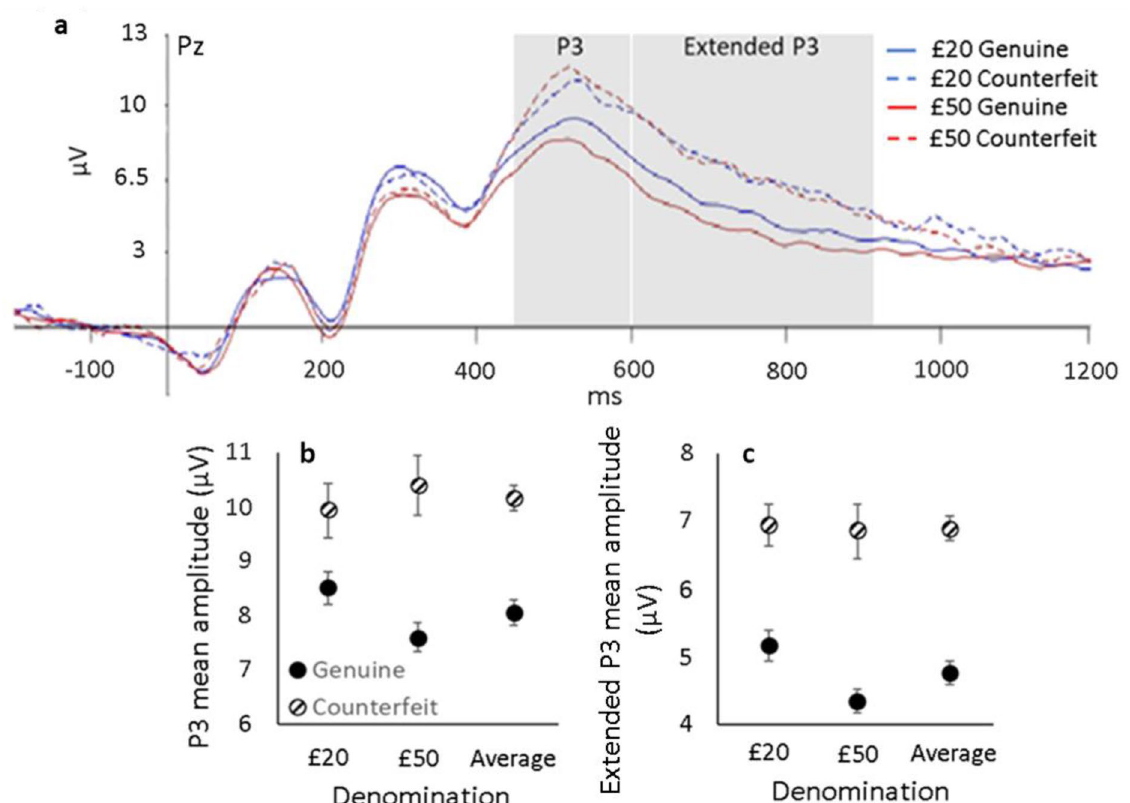
Figure 2. ( a ) ERP for each denomination and authenticity at electrode location Pz, where the P3 component mean amplitude within the 450–600 ms window is calculated. Blue lines represent £20 notes, red lines represent £50 notes. Solid lines are genuine notes, dashed lines are counterfeit notes. Positive is plotted up. Shaded rectangle indicates the general time interval for each component. Group mean amplitude at the P3 ( b ) and the extended P3 ( c ) components plotted for each authenticity and denomination (including the average of each denomination). Error bars represent ± 1 within-subject S.E of the mean 30 .